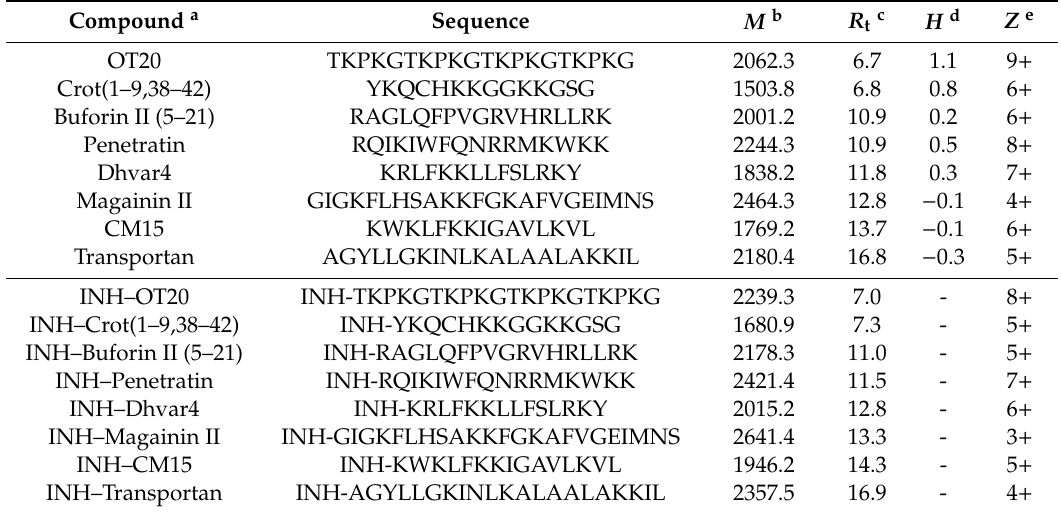
Table 1. Analytical characterization of the peptides and INH–peptide conjugates studied in this work. Compound a